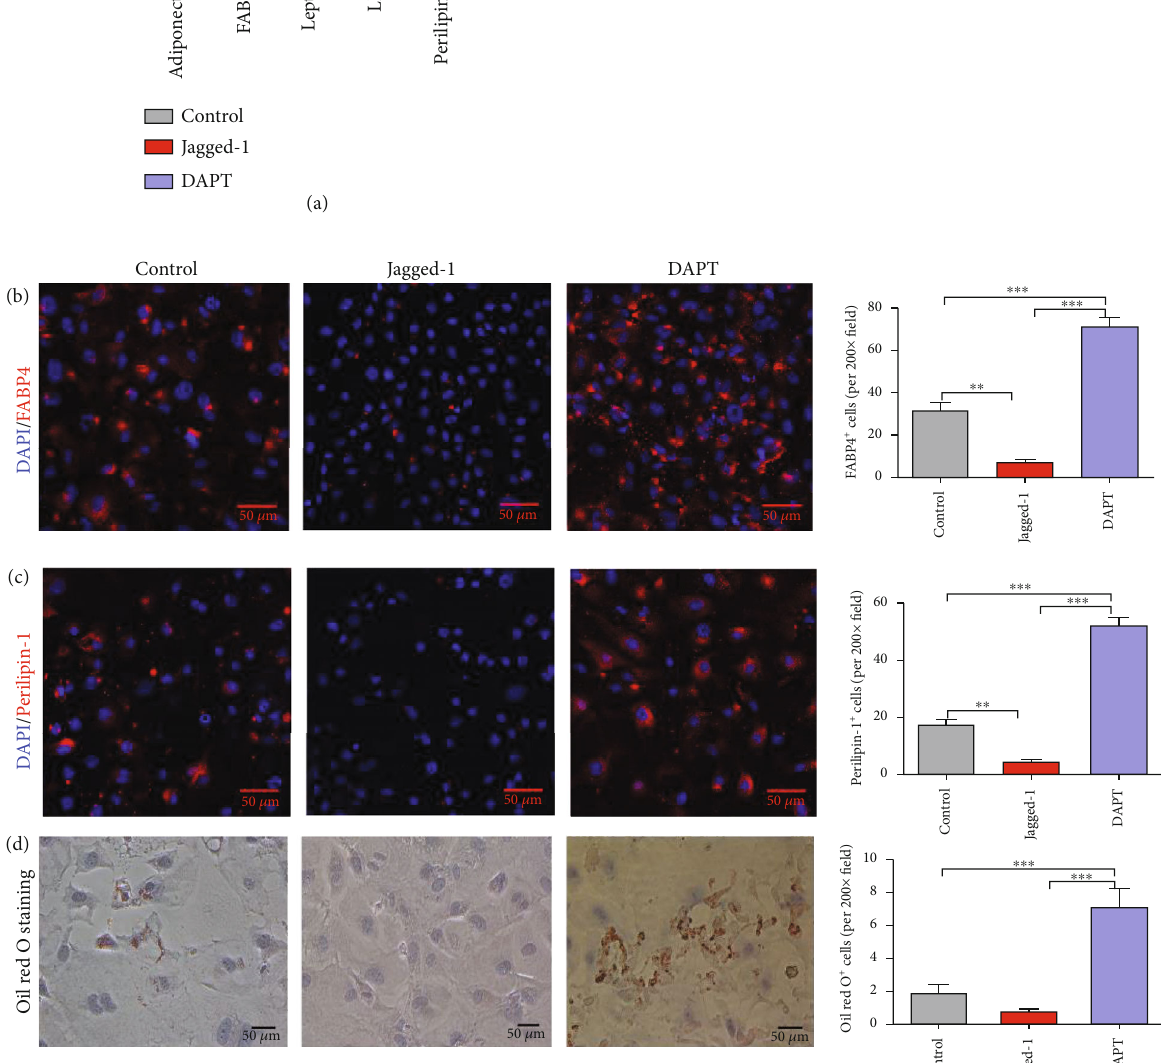
Figure 4: Inhibition of Notch signaling promoted the adipogenic di ff erentiation of EPCs. (a) The mRNA expression levels of adipocyte- related genes adiponectin, FABP4, leptin, LPL, and perilipin-1 were determined by RT-PCR after EPCs cultured in adipogenic induction medium alone, with jagged-1, or with DAPT for 7 days. (b, c) The adipocyte markers FABP-4 and perilipin-1 were determined by immuno fl uorescence staining after EPCs were cultured in adipogenic induction medium alone, with jagged-1, or with DAPT for 7 days. (d) Lipid droplet accumulation was detected by Oil red O staining after EPCs cultured in adipogenic induction medium alone, with jagged-1, or with DAPT for 21 days. The p values were calculated by ANOVA. ∗ p < 0 : 05 , ∗∗ p < 0 : 01 , and ∗∗∗ p < 0 : 001 for pairwise comparison among the